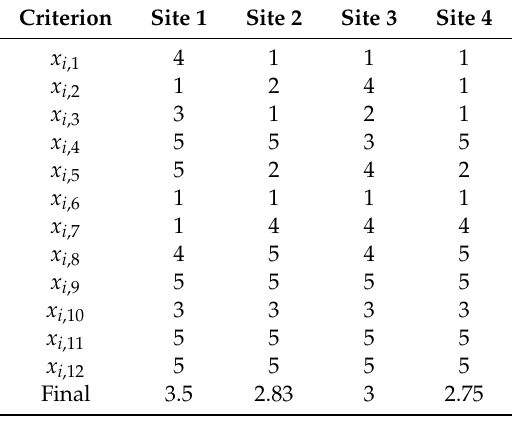
Table 15. Ranking of the selected geothermal sites in this study for electricity production. Criterion